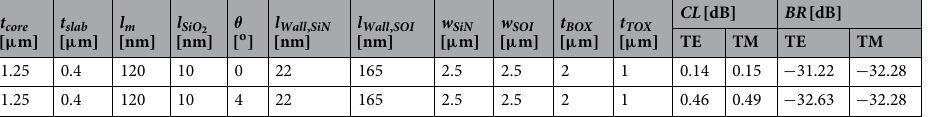
Table 1. Geometric parameters of the waveguide-to-waveguide interface. The values for the coupling loss ( CL ) and the back-reflection ( BR ) are recorded investigating the fundamental TE and TM cases. The back-reflection values are related in each case only to the fundamental mode. The cases of a flat and a tilted interface are